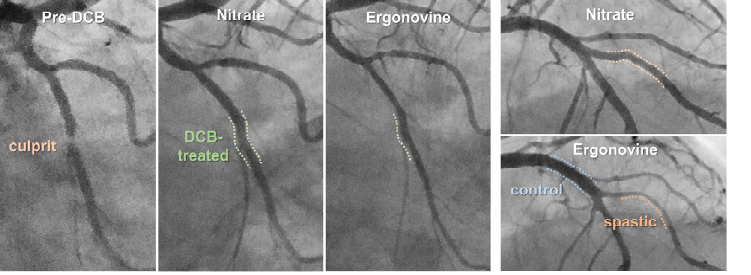
Figure 1. Representative case showing the three comparative arterial segments. In this patient who received DCB angioplasty at left circumflex artery, proximal left anterior descending artery serves as angiographically normal segment and big diagonal branch serves as spastic counterpart. DCB: drug-coated balloon.